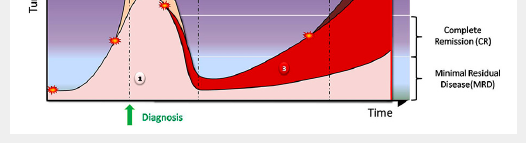
Clonal evolution during chemotherapy. Tumour clones derive from somatic mutations (stars). The original parent clone (1) can give rise to subclones (2, 4). Additional mutations due to chemotherapy/radiotherapy can also trigger the development of new subclones (3). Therapy eliminates some clones (2) but some others (1, 3) survive and are detected as minimal residual disease. Clonal composition may be very different between the initial diagnosis and after